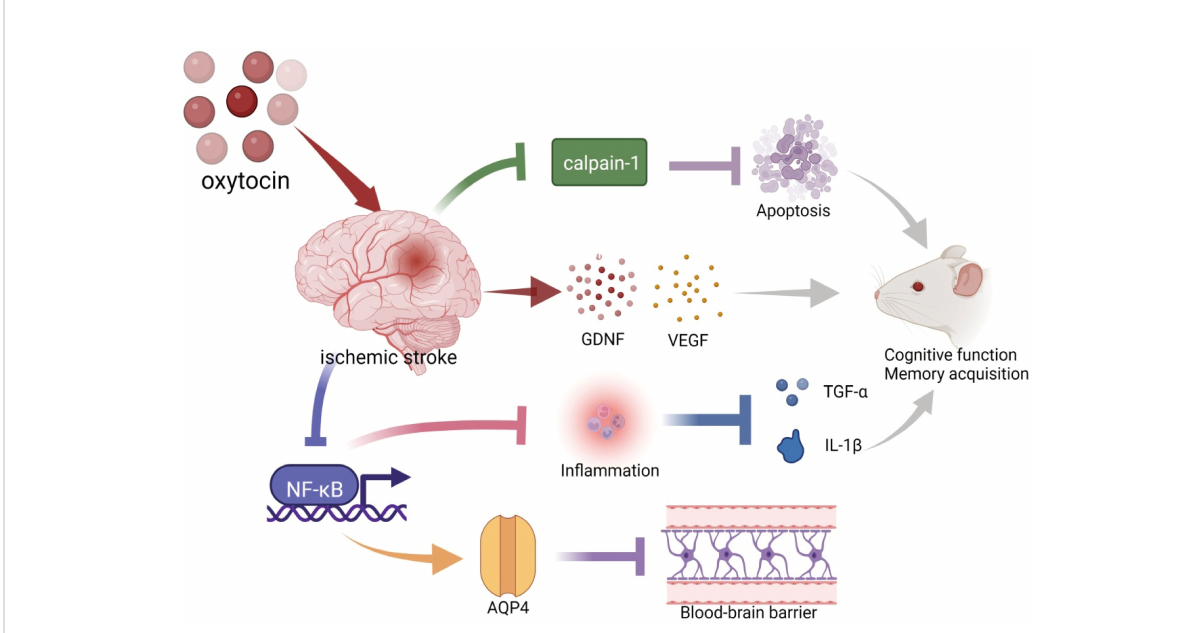
FIGURE 1 Schematic illustration of oxytocin and ischemic stroke. OT decreased ischemia-induced Caipain-1 overexpression to inhibit apoptosis. Pretreatment with OT before ischemic stroke promoted the expression of BDNF and VEGF. OT suppressed in fl ammation (TNF- a and IL-1 b ) by inhibiting the expression of NF- k B. These are bene fi cial for the recovery of cognitive function after an ischemic stroke. In addition, OT attenuated blood-brain barrier leakage and cerebral hematoma by promoting the expression of AQP4, which may be associated with the inhibition of NF- k B. BDNF, brain-derived neurotrophic factor; VEGF, vascular endothelial growth factor; TNF- a , tumor necrosis factor- a ; IL-1 b , Interleukin-1 beta; AQP4, Aquaporin 4. The illustration was supported by BioRender